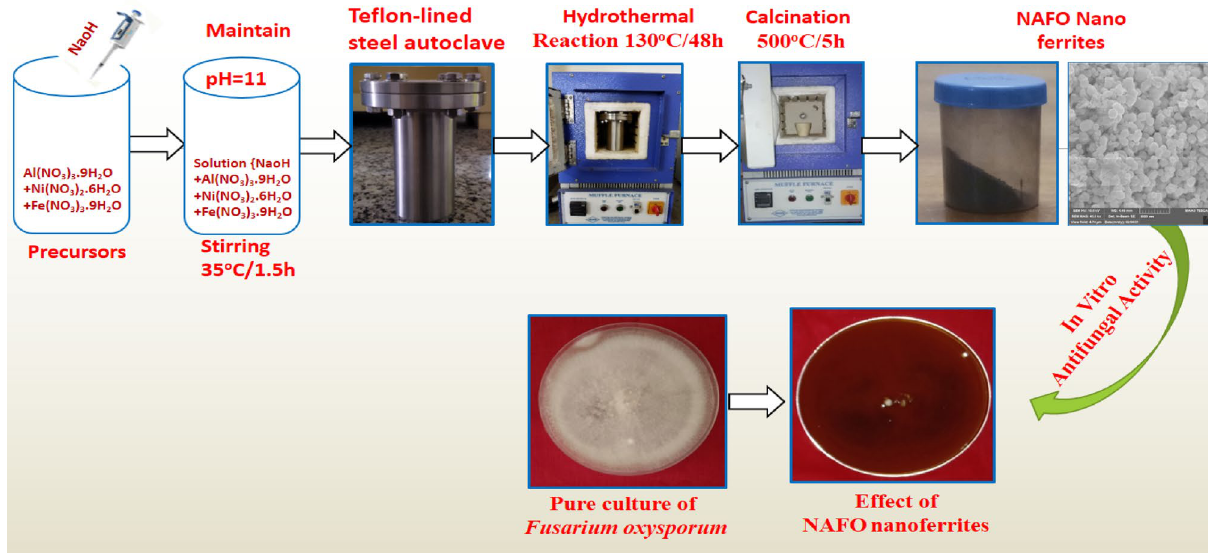
Figure 1. Schematic representation of NAFO nanoparticles preparation and its antifungal activity.